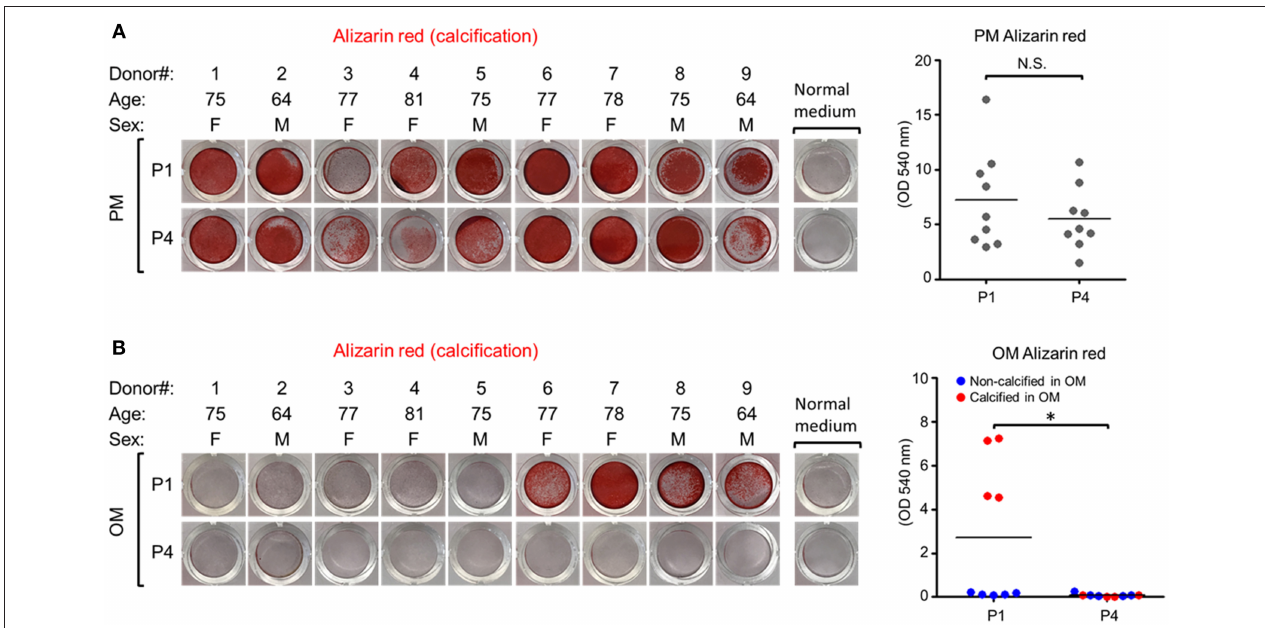
FIGURE 1 | Human valvular interstitial cell (VIC) calcification was donor- and passage-dependent in osteogenic media (OM) but not passage-dependent in pro-calcifying media (PM). (A) Alizarin red calcification stain and quantification of human calcific aortic valve disease tissue-derived VICs in normal control media (NM) or PM at passage one (P1) and passage four (P4), or in OM (B) . Quantification presented as dot plots, bar indicates group mean, and for the OM dataset dots are distinguished by calcification-prone (calcified in OM, indicated by red dots) and calcification-resistant donors (non-calcified in OM, indicated by blue dots). n = 9 donors/media condition, F, female; M, male; N.S., non-significant; * P < 0.05 analyzed by t -test.